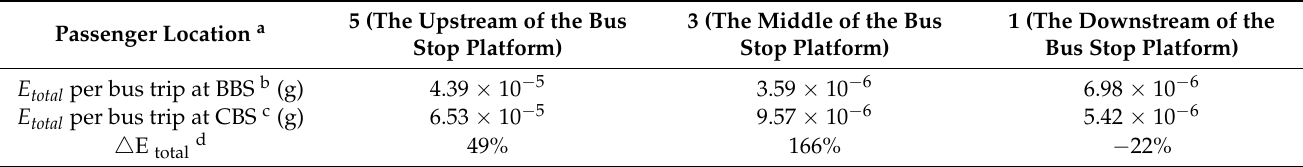
Table 9. Total exposure at different types of bus